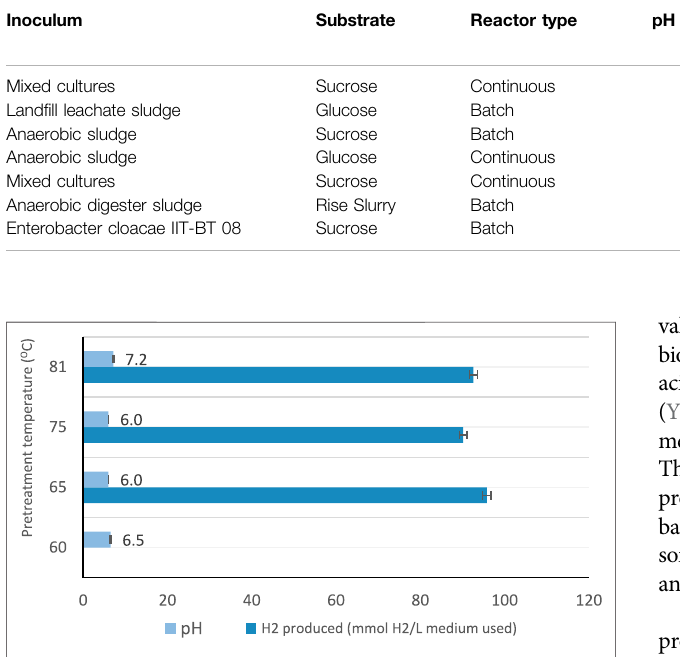
FIGURE 3 | Effect of heat pretreatment and pH on hydrogen produced (without